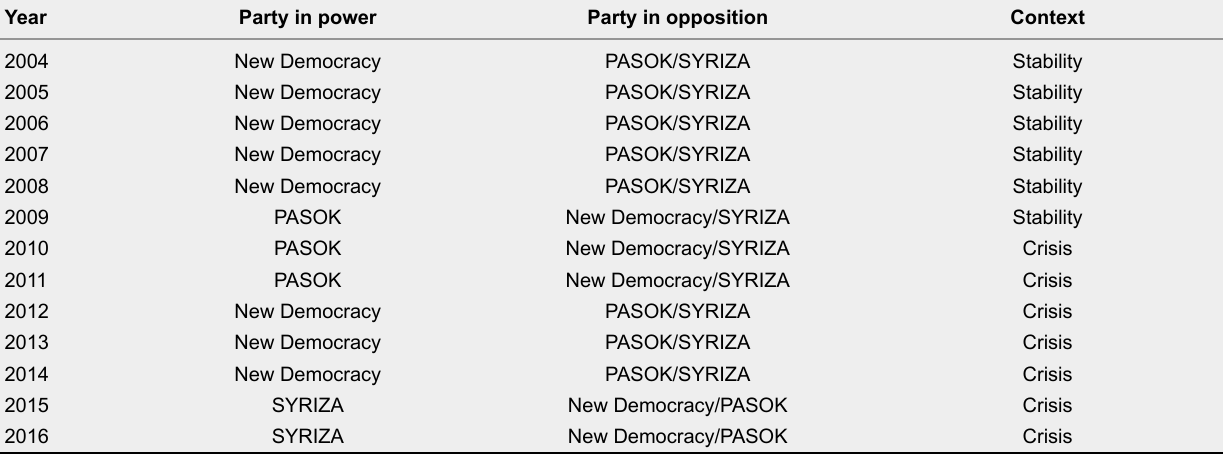
Political Parties and Their Status According to High or Low Number of Candidates in Elections Over 13 Years